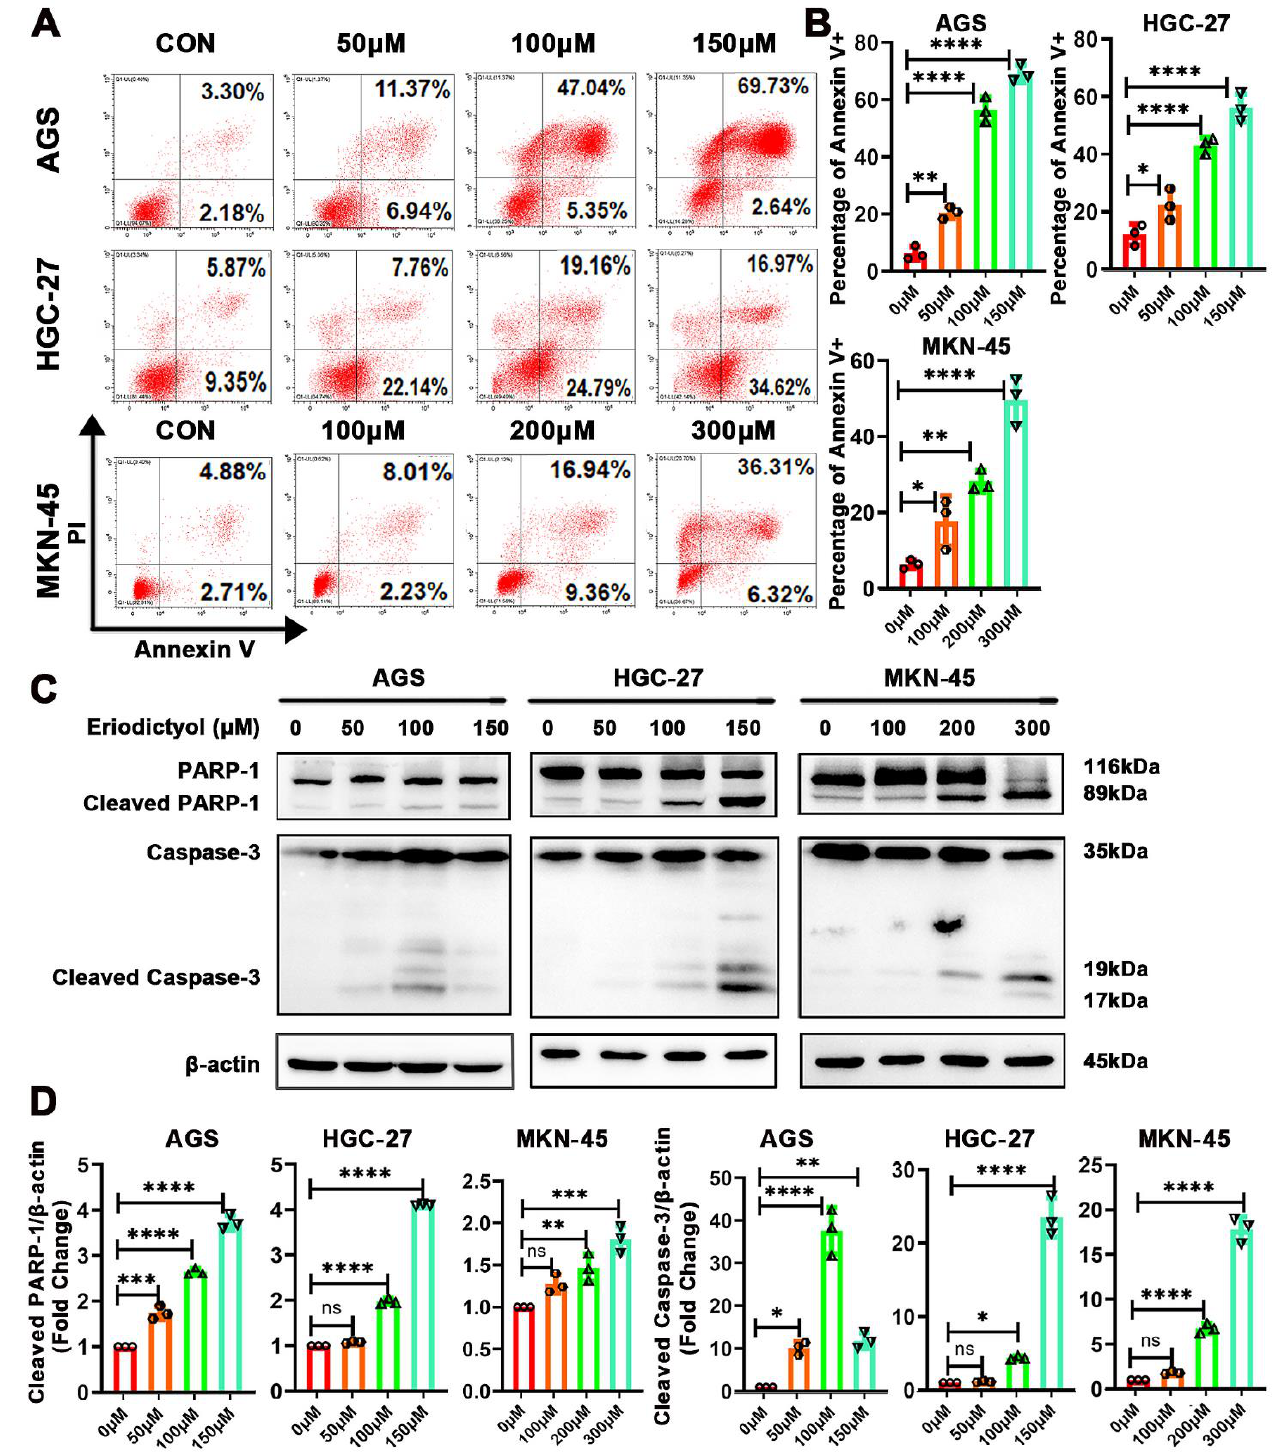
Figure 3. Eriodictyol induces cell apoptosis in GC cells. ( A ) Cells in early and late apoptotic stages were detected with Annexin V/PI stain and flow cytometry analysis. ( B ) The quantitative analysis of Annexin V-positive percentages is demonstrated as a histogram. ( C ) The levels of PARP-1, cleaved PARP-1, Caspase-3, and cleaved Caspase-3 were measured with Western blotting. ( D ) The relative protein levels of cleaved PARP-1 and cleaved Caspase-3 were quantified and are demonstrated as a histogram. Three independent experiments were performed, and data are presented as mean ±